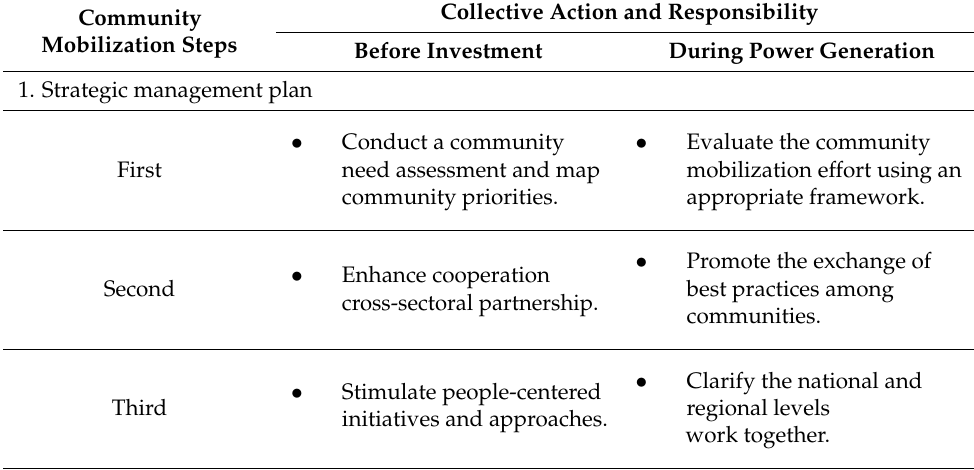
Table 5. Overview of convening presentations and panel discussions for community capacity building using the CHIA process (N =